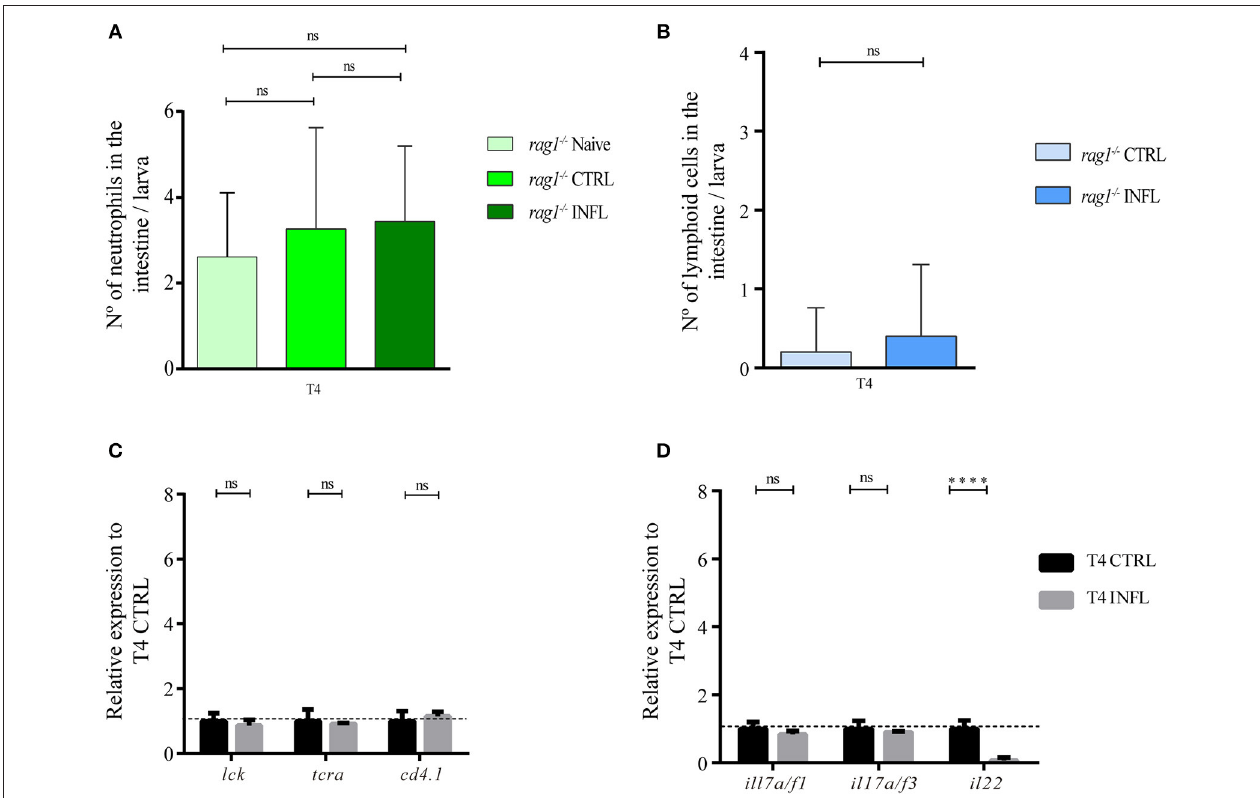
FIGURE 5 | Soybean meal based inflammatory diet triggered intestinal inflammation in a T cell dependent manner. (A) Neutrophils quantification in naïve, control and inflamed rag1 − / − Tg(lck:lck-eGFP) larvae fed according to naïve model. (B) Lymphoid cells (lck + cells) quantification in control and inflamed rag1 − / − Tg(lck:lck-eGFP) larvae fed according to naïve model. (C–D) Relative transcriptional level of lymphoid-associated genes were analyzed. Data was normalized against rpl13a and compared to the control condition (T4; dotted line). Neutrophils and lymphoid cells quantification were done at least in three biological replicates and with 20 individuals per condition. For each condition in RT-qPCR, 100 guts were analyzed, and three biological replicates were made. **** p > 0.0001.